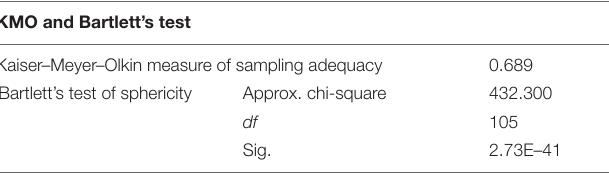
TABLE 2 | Kaiser–Meyer–Olkin and Bartlett’s test for principal component analysis (PCA).